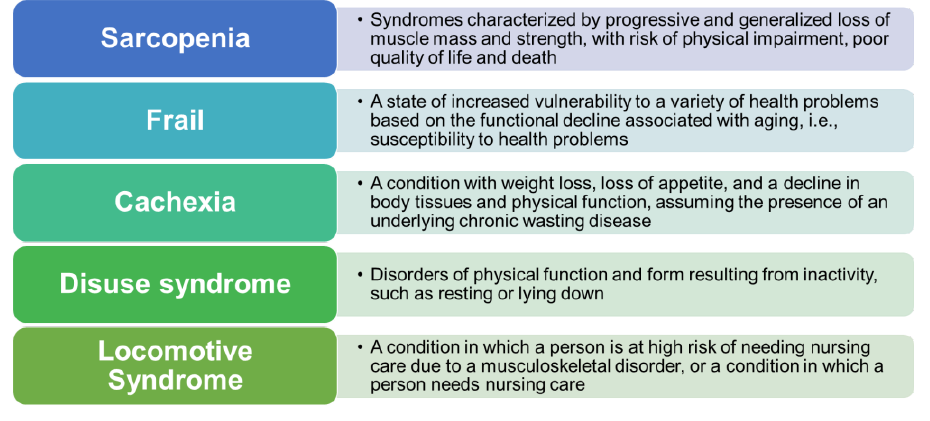
Figure 1. Sarcopenia and other related hypoactivity syndromes.